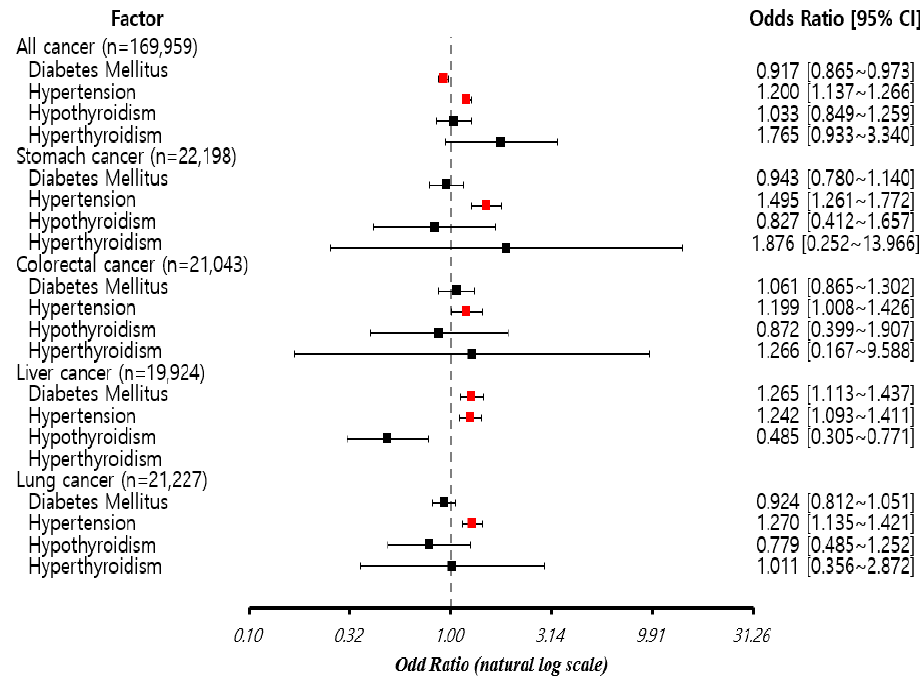
Figure 2. Forest plot of the impact of mortality according to cancer type.